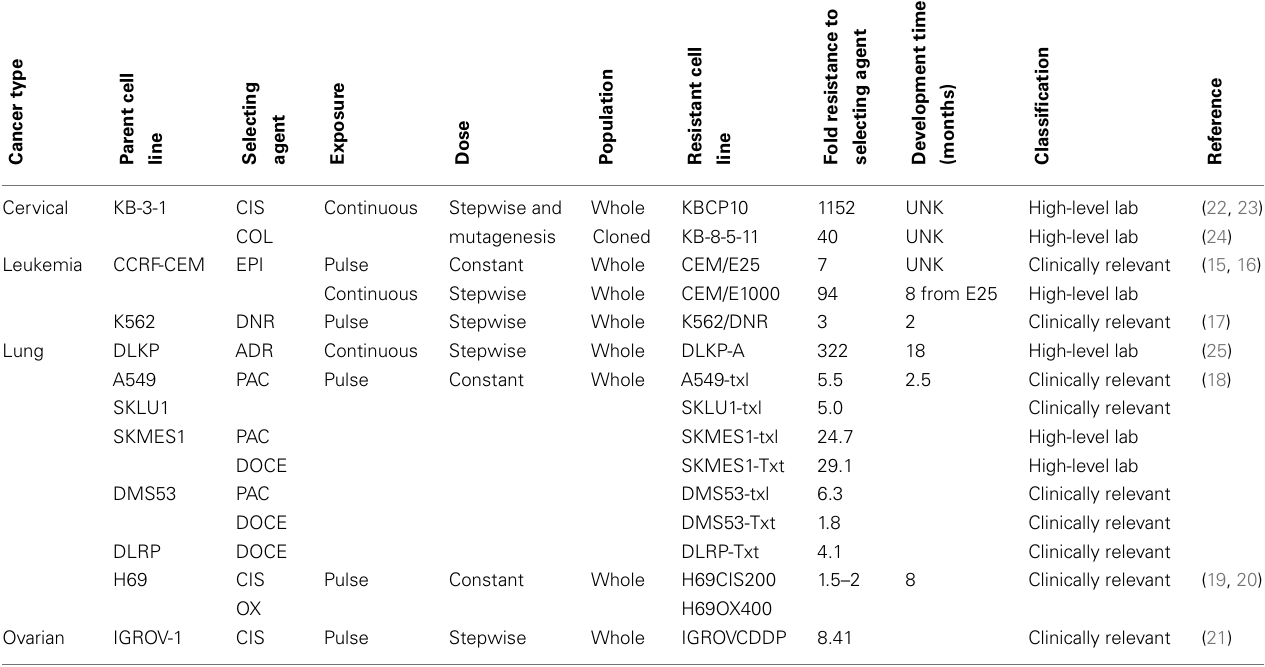
Table 2 | Different selection strategies and classification of resulting drug-resistant cell lines .